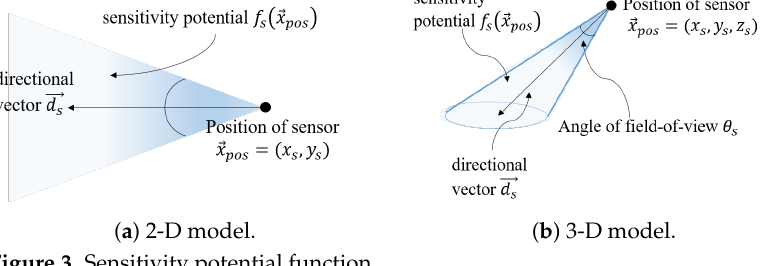
Figure 3. Sensitivity potential